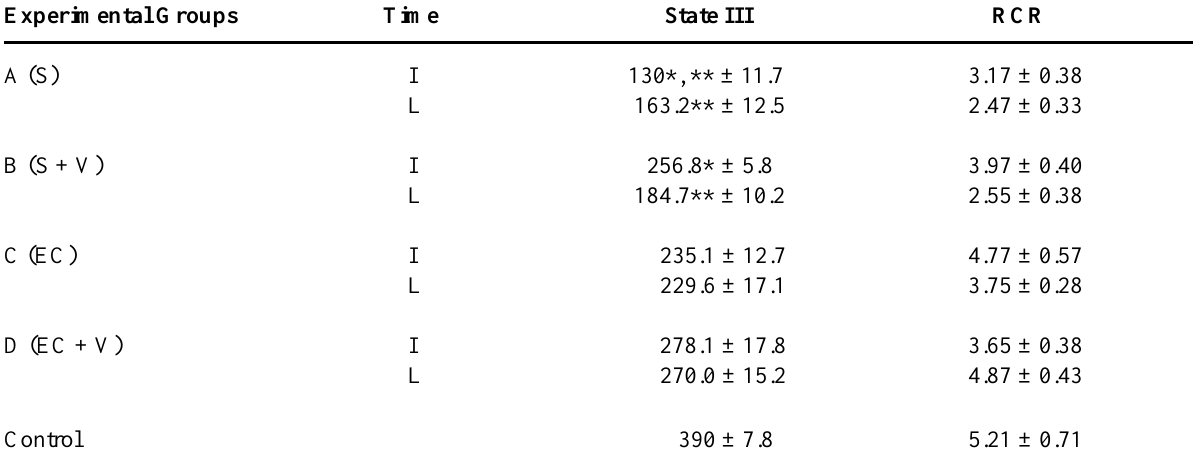
Table 1 – Data concerning state III of mitochondrial respiration and respiratory control ratio (RCR) (mean ± standard